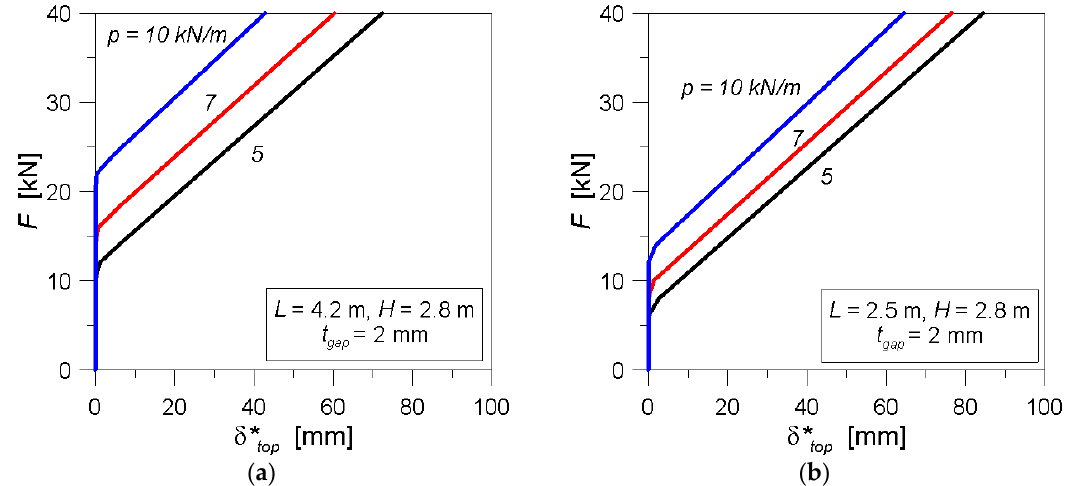
Figure 12. Example of “FPD” charts for log-house timber walls under in-plane lateral loads, with ( a ) L = 4.2 m and ( b ) L = 2.5 m.